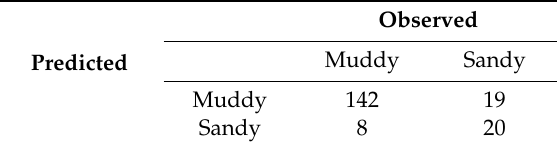
Table A9. Categorical muddy / sandy LOO CV error matrix.